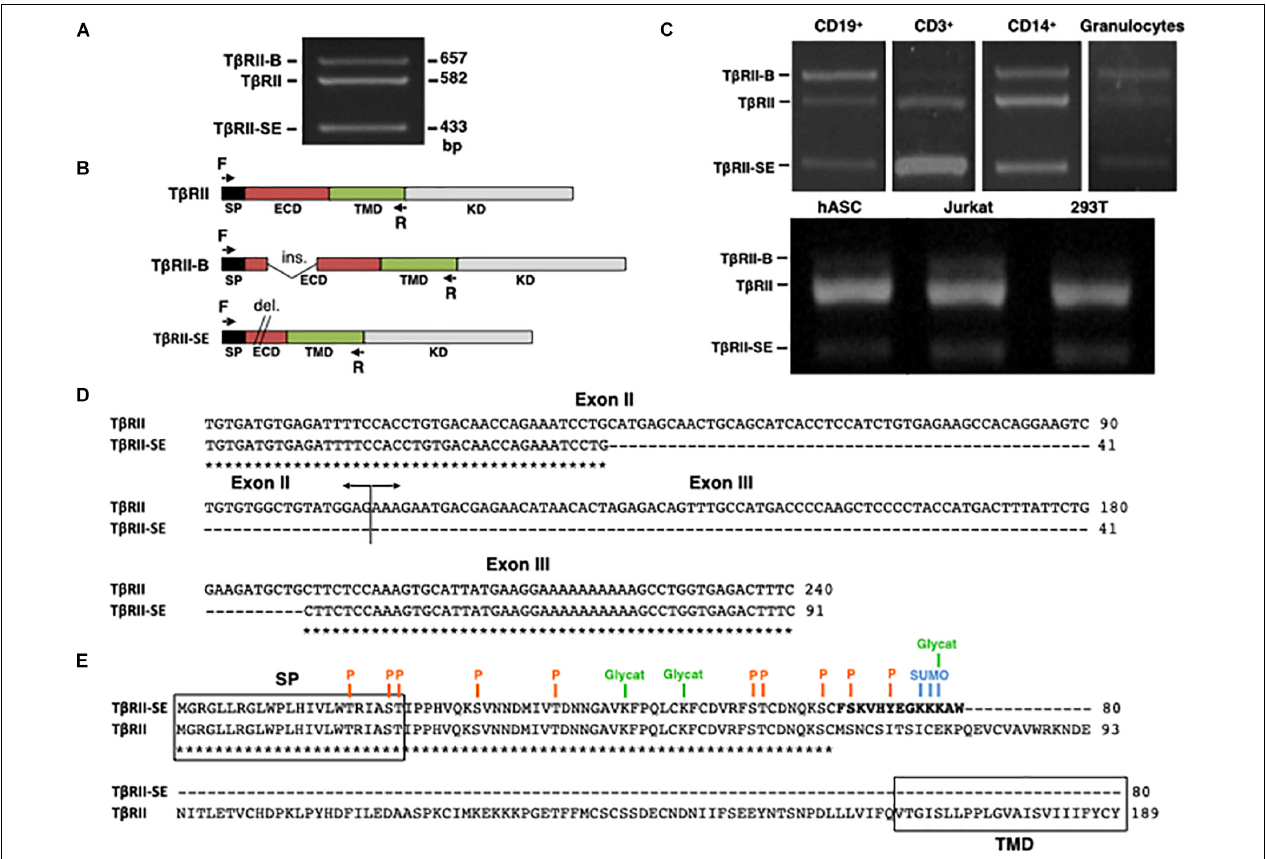
FIGURE 1 | T β RII-SE splice variant is produced by human cells and is able to generate a truncated soluble protein. (A) T β RII-SE was originally detected in human lymphocytes as a 433-bp band after end point RT-PCR. (B) Primers design to amplify the coding sequence of the endoplasmic reticulum signal peptide (SP), extracellular domain (ECD), and transmembrane domain (TMD) of membrane-bound T β RII splice variants. (C) End point RT-PCR of PBMC isolated CD3 + , CD19 + , CD14 + cells, and granulocytes; and human adipose stromal cells (hASC), immortalized T lymphocyte cell line (Jurkat), and human embryonic kidney cell line containing the SV40 T-antigen (293T). (D) Partial nucleotide sequence alignment of T β RII and T β RII-SE depicting the stretch absent in the new splice variant. (E) Predicted amino acid sequence alignment of T β RII and T β RII-SE showing the presence of the SP and predicted PTM in both isoforms, and the absence of